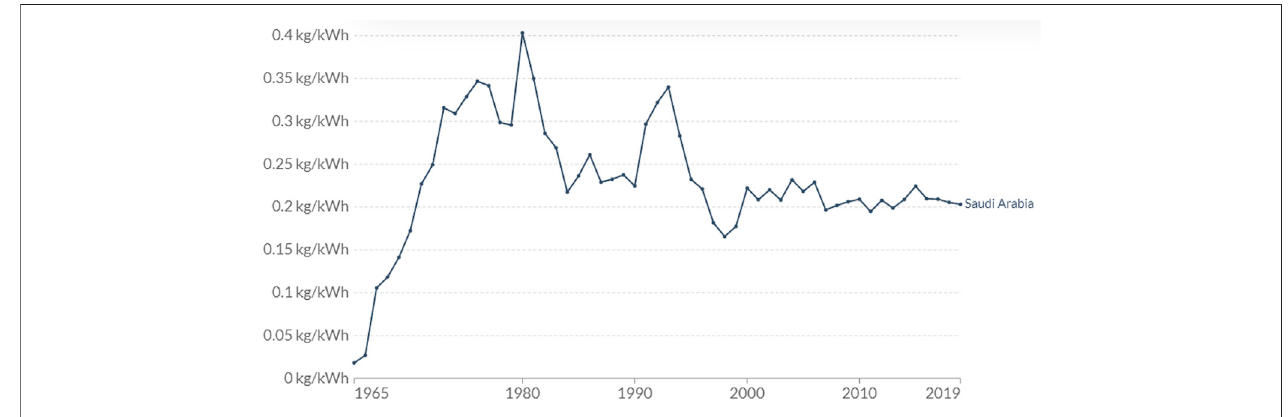
FIGURE 1 | Carbon intensity per kilogram of oil equivalent oil consumed (Ritchie and Roser,